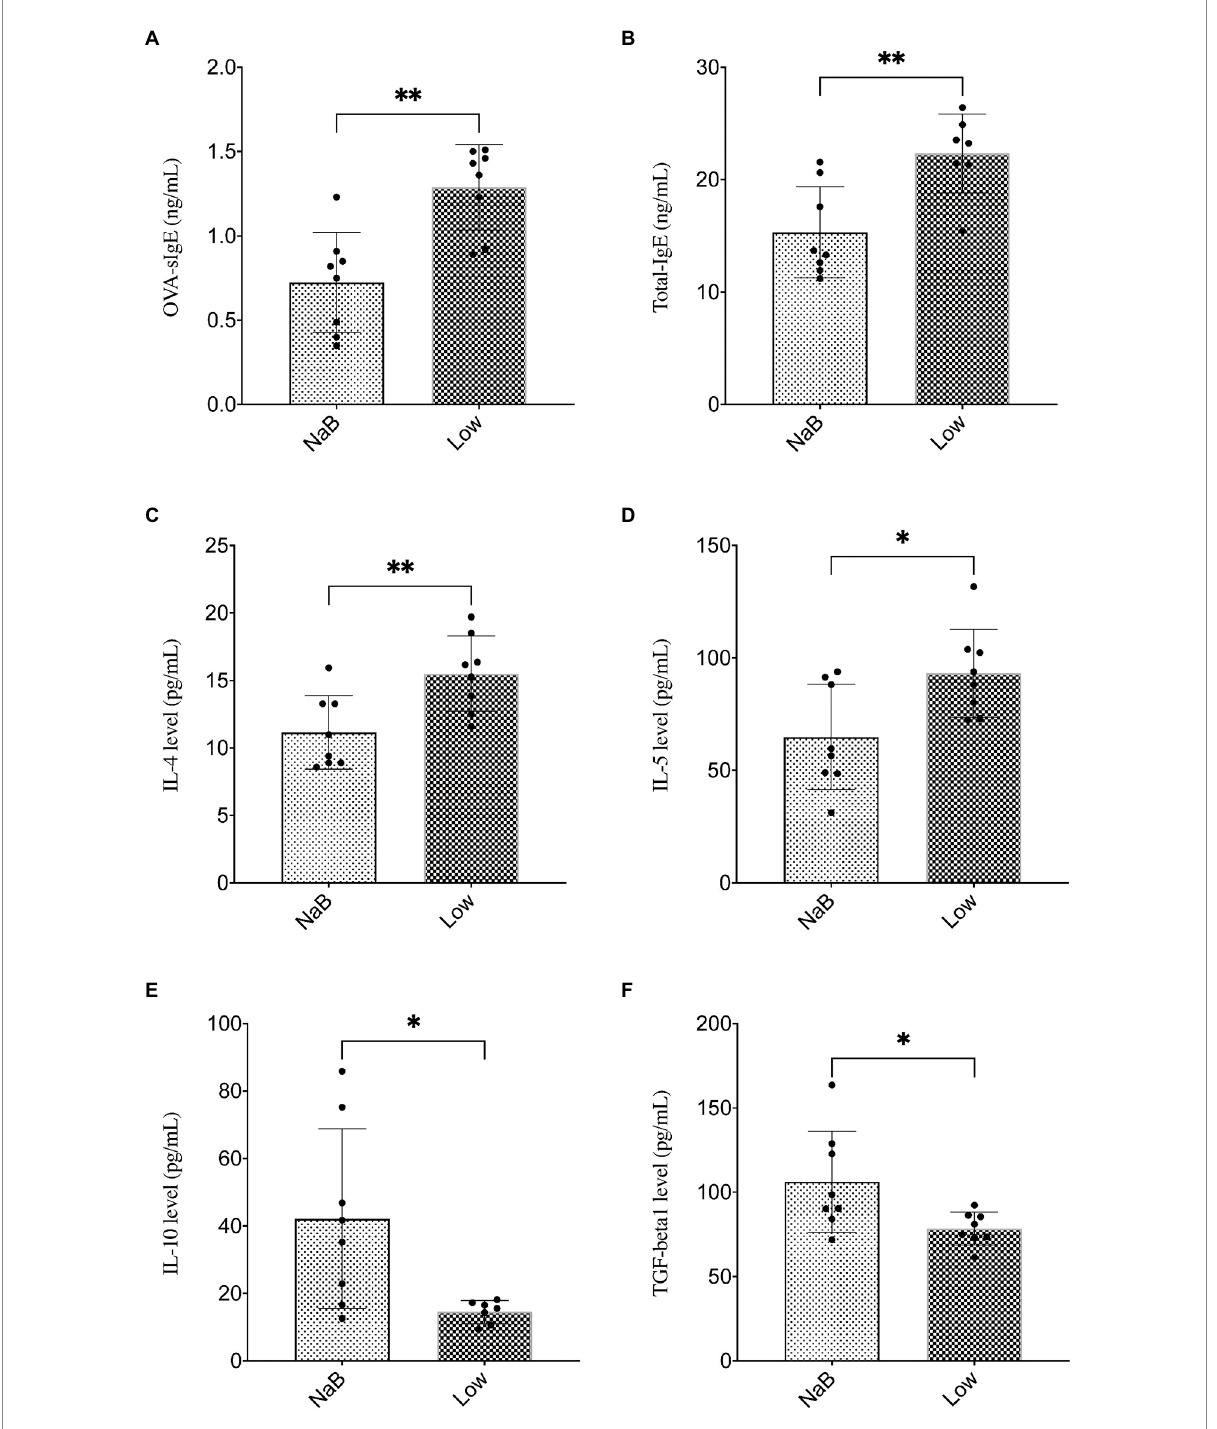
FIGURE 11 Butyrate alleviated symptoms in AR mice fed a low dietary fiber basal diet. (A,B) ELISA detection of OVA-sIgE and total IgE in serum. (C–F) ELISA detection of serum cytokines (IL-4, IL-5, IL-10, and TGF- β 1). ∗ p < 0.05, ∗∗ p <